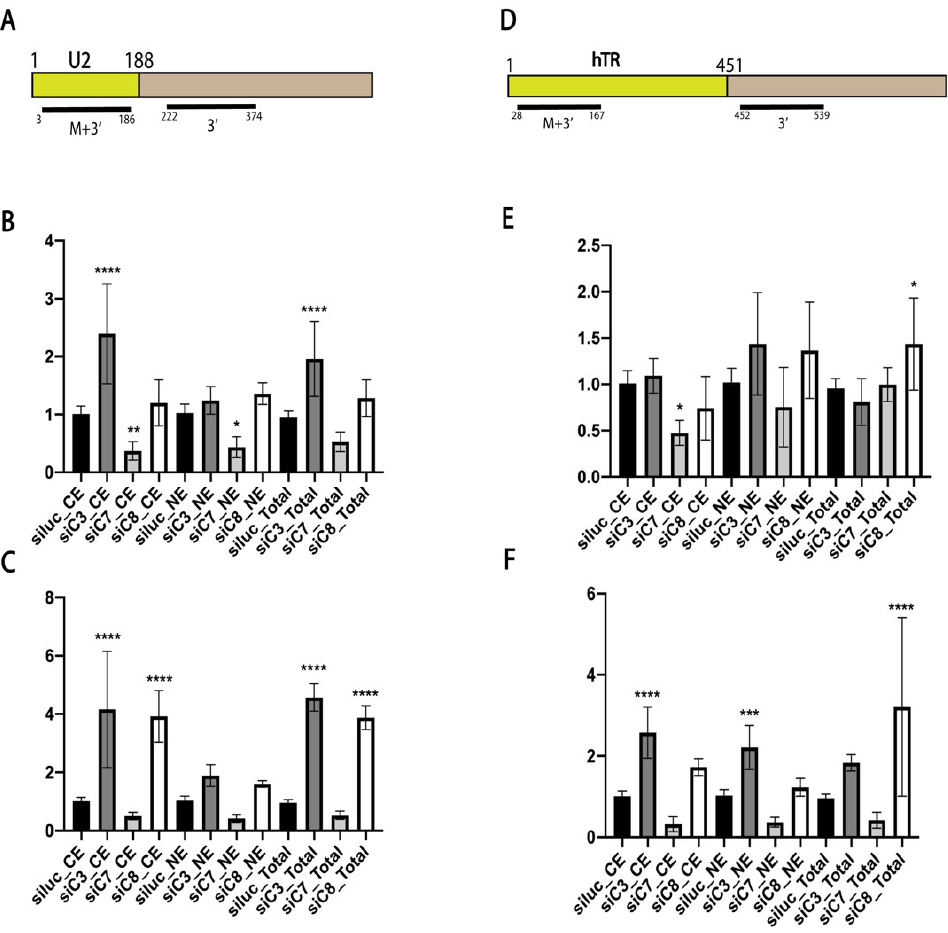
Figure 1. The role of RNA exosome-associated factors in processing and transport of U2 snRNA and hTR. ( A ) Scheme illustrating regions of U2 snRNA that were amplified as total (M+3′) and unmatured transcript (3′). ( B ) Histograms demonstrating the relative amount of total (M+3′) U2 snRNA transcripts in the cytoplasmic (CE) and nuclear (NE) fractions and in the whole cell extract (Total) after the knockdown of the specified RNA biogenesis factor. siluc—control knockdown performed with siRNA specific to Firefly luciferase mRNA; siC3 — knockdown performed with siRNA specific to ZFC3H1; siC7 — knockdown performed with siRNA specific to ZCCHC7; siC8 — knockdown performed with siRNA specific to ZCCHC8. ( C ) Histograms demonstrating the relative amount of premature (3′) U2 snRNA transcripts in the cytoplasmic (CE) and nuclear (NE) fractions and in the whole cell extract (Total) after the knockdown of the specified RNA biogenesis factor. ( D ) Scheme illustrating regions of hTR that were amplified as total (M+3′) and unmatured transcripts (3′). ( E ) Histograms demonstrating the relative amount of total (M+3′) hTR transcripts in the cytoplasmic (CE) and nuclear (NE) fractions and in the whole cell extract (Total) after the knockdown of the specified RNA biogenesis factor. ( F ) Histograms demonstrating the relative amount of the premature (3′) hTR transcripts in the cytoplasmic (CE) and nuclear (NE) fractions and in the whole cell extract (Total) after the knockdown of the specified RNA biogenesis factor. * p < 0.1, ** p < 0.01, *** p < 0.001, and **** p < 0.0001 by Dunett’s multiple comparison test.